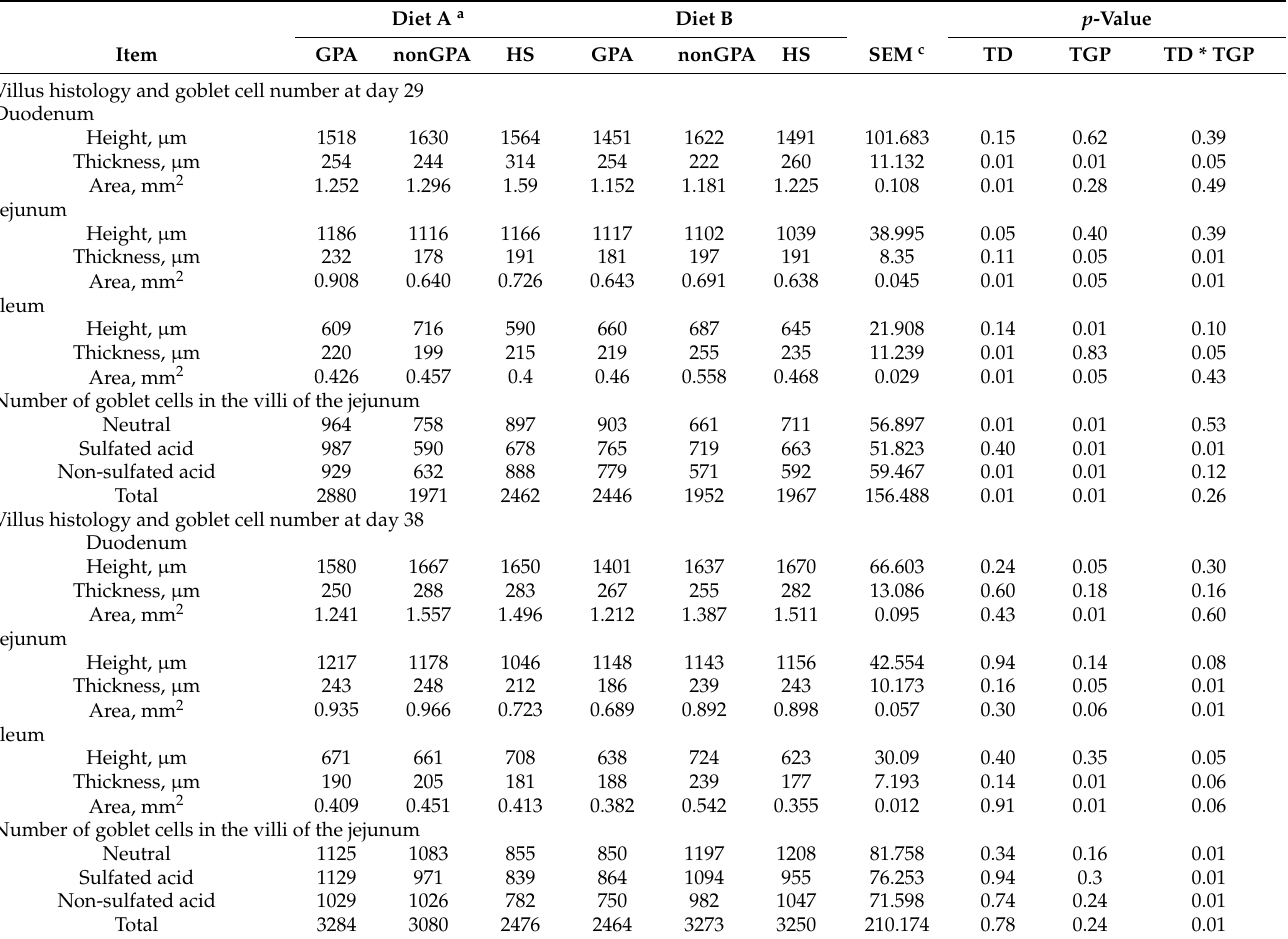
Table 5. Effect of the interaction of the type of growth promoter and type of diet on the villus histology and goblet cell number at day 29 and 38 a,b